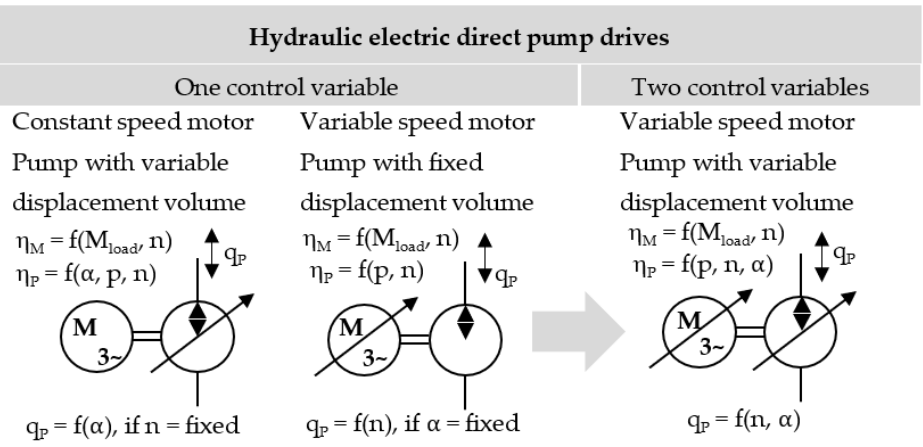
Figure 1. Hydraulic pump drives with one and two degrees of freedom to vary volume